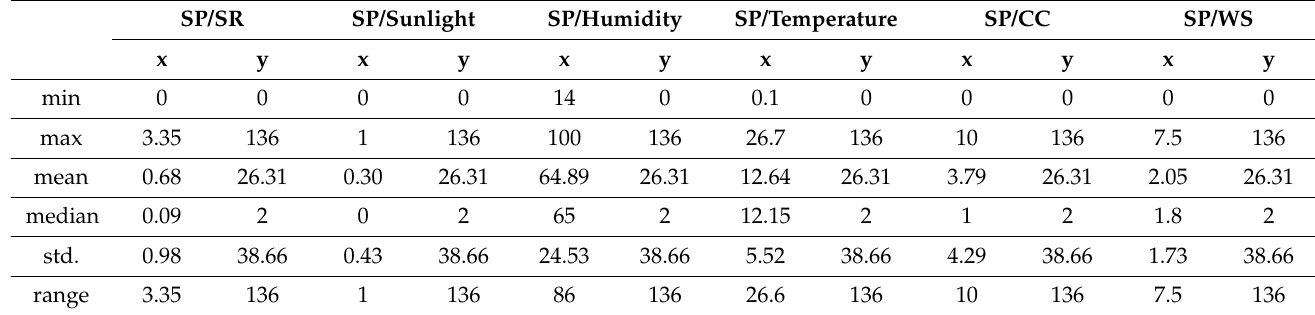
Table 2. Statistical data (Min, max, mean, median, standard deviation, and range) of solar power vs. meteorological factors. SP/SR SP/Sunlight SP/Humidity SP/Temperature